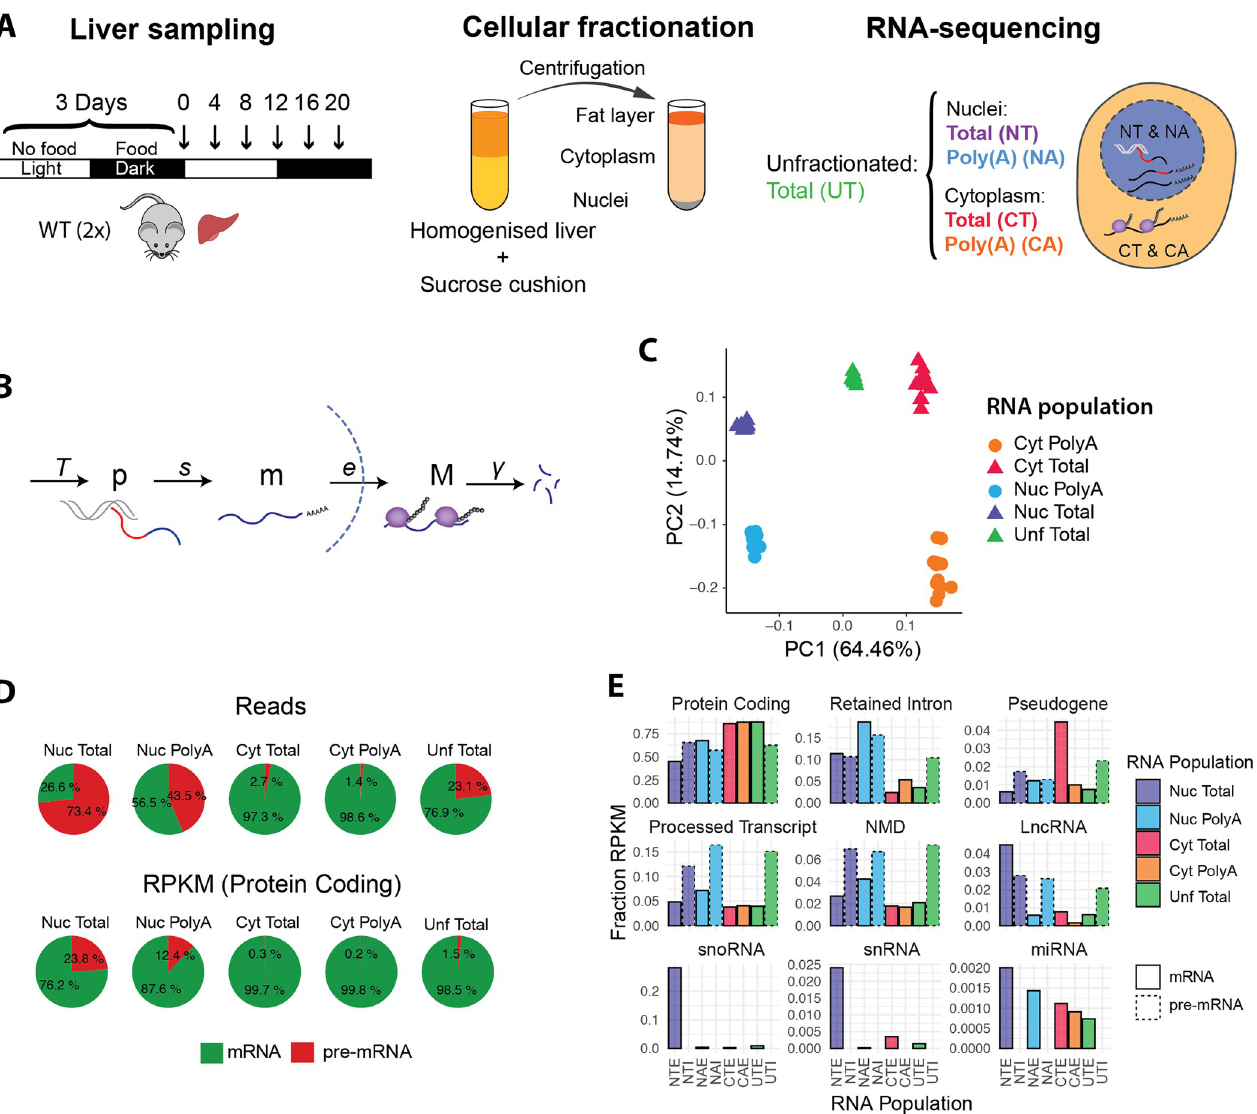
Fig 1. Global characteristics of Poly(A) and Total RNA populations in nuclear and cytoplasmic fractions. A : Experimental design: 12 WT mice were kept in a 12:12 light-dark cycle. Food was given only during the dark phase (active phase). The night-restricted feeding regimen started 3 days prior to the sampling. Livers were collected every 4 hours (n = 2), homogenised, and centrifuged in a sucrose cushion as described in [23]. RNA from cytoplasmic and nuclear fraction were extracted. rRNA-depleted Total RNA (T) and Polyadenylated RNA (A) from nuclear and cytoplasmic fractions were sequenced. Total RNA from unfractionated liver tissues was also sequenced as an internal reference set. B : Representation of each RNA processing step modelled in this study: starting with the transcription by RNA Polymerase II (at a rate T ), splicing of the introns (red segment) and addition of a poly(A) tail at the 3’ end ( s ), export to the cytoplasm ( e ), and degradation ( γ ). p = pre-mRNA, m = nuclear polyadenylated mRNA, M = cytoplasmic mRNA. C : Principal Component Analysis using mRNA (signal from exonic regions only). PC1 separates nuclear from cytoplasmic samples, and PC2 separates Total from Poly(A) samples. Each datapoint represents one time point. D : Percentage of reads mapping on pre-mRNA or mRNA transcripts in each condition (up). Proportion of RPKM (reads normalised by gene length) of protein coding transcripts mapping on pre-mRNA and mRNA (bottom). E : Fraction of each biotype in each RNA sample. Solid lines represent mRNA (first bar), dotted lines represent pre-mRNA (second bar). Pre-mRNA from cytoplasmic fractions are not shown. using the pseudo-alignment algorithm implemented in Kallisto [28] (S1 Table), by providing as a reference the annotation of transcript sequences (isoform) of both pre-mRNA (intronic and exonic regions, labelled I) and mRNA (exonic regions only, labelled E). Nuclear Total pre- mRNA (NTI), Nuclear Poly(A) mRNA (NAE), and Cytoplasmic Poly(A) mRNA (CAE) were